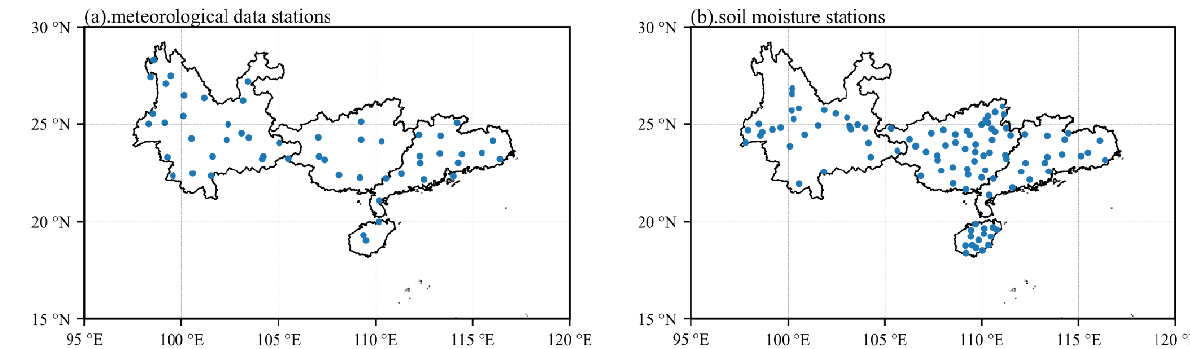
Figure 2. ( a ) Distribution of meteorological data stations; ( b ) distribution of soil moisture stations.